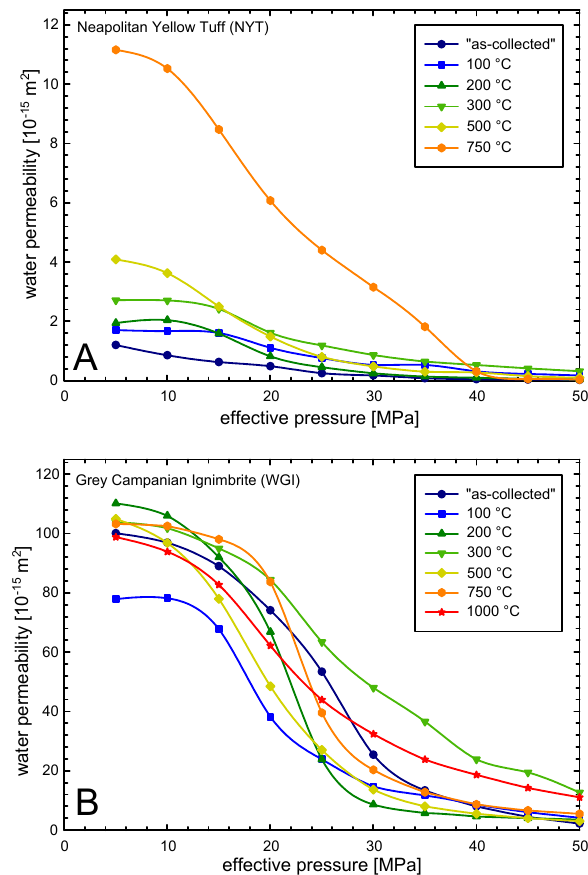
Fig. 6. The evolution of water permeability with increasing effec- tive pressure for Neapolitan Yellow Tuff (A) and Grey Campanian Ignimbrite (B) . The temperatures in the legend refer to the thermal stressing temperature (see text for